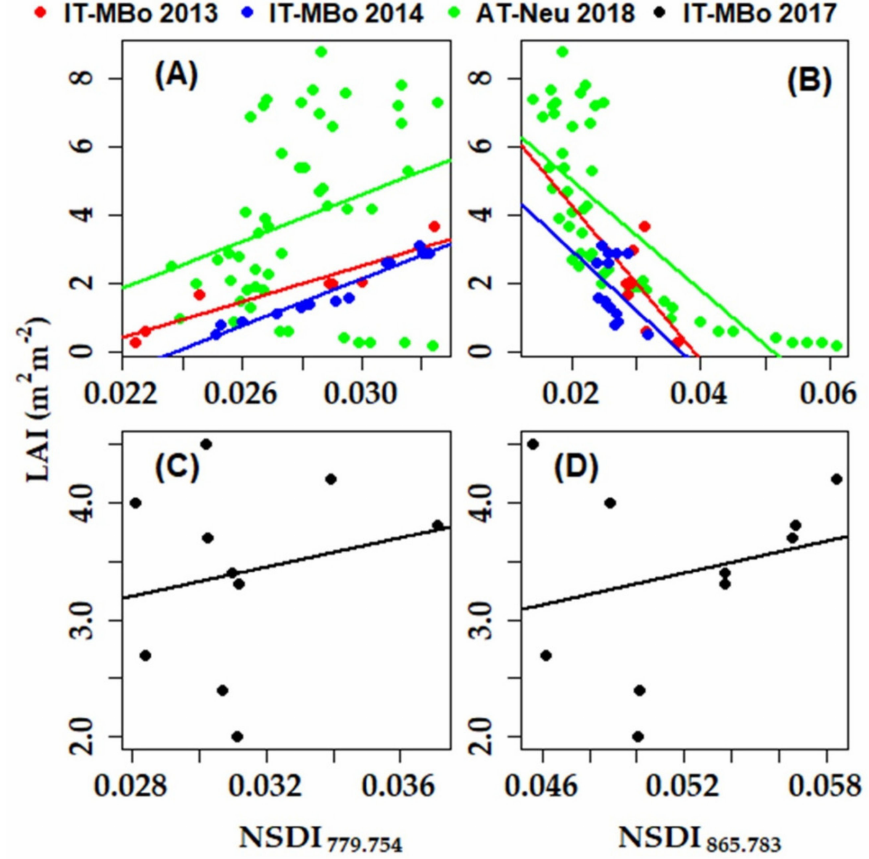
Figure 8. Relationship between NIR-shoulder indices and LAI: for temporal observations at IT-MBo (2013 and 2014) and AT-Neu 2018, respectively ( A , B ); and for spatial observations at IT-MBo 2017 ( C , D ). In all panels, solid lines represent a linear fit to the